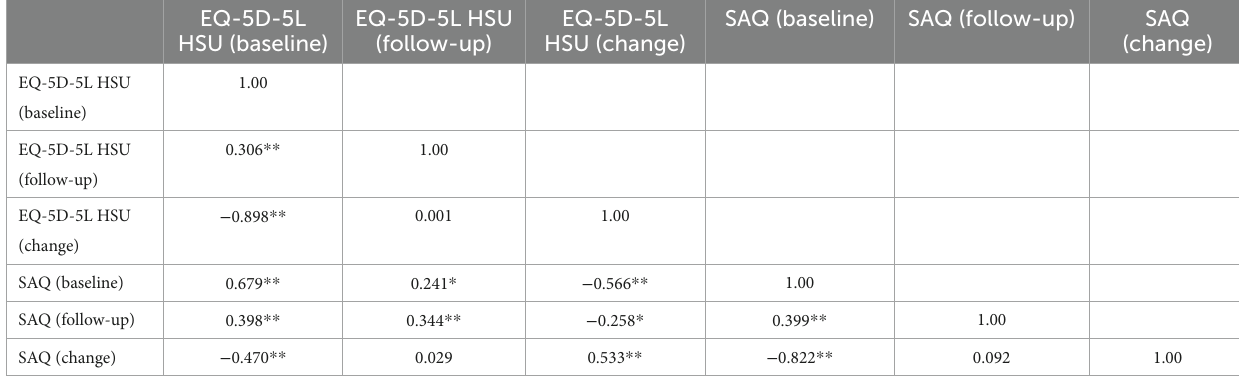
TABLE 4 The Spearman correlation between EQ-5D-5L HSU and SAQ.